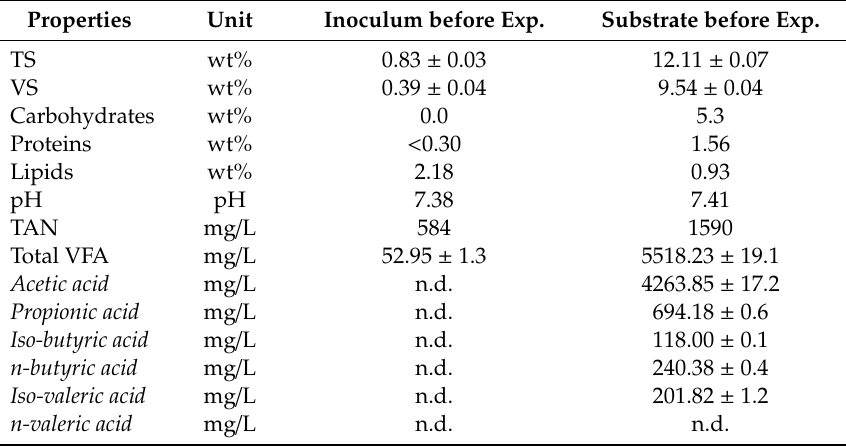
Table 2. Measured properties of inoculum and